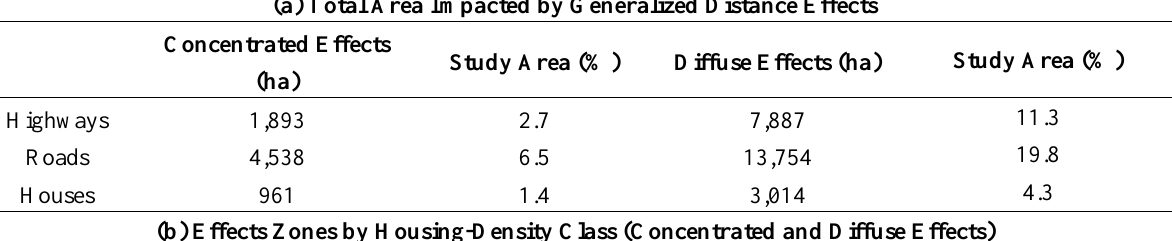
Table 6. Generalized distance effects of houses, roads and highways: ( a ) the areas impacted by the concentrated and diffuse effects of houses, roads, and highways; ( b ) the percentage area of each housing-density class impacted by distance effects; ( c ) the cumulative impacts of distance effects, by housing-density